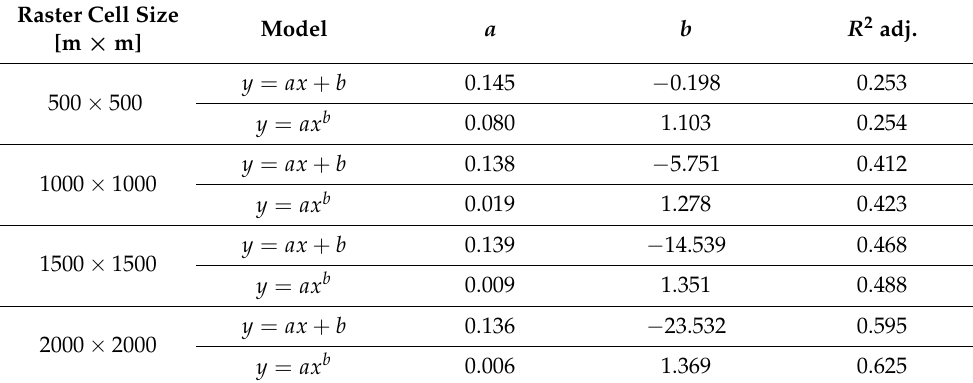
Table 1. Functional forms, values of parameters, and adjusted R 2 obtained when modelling the dependency between the number of emergency cases and the residential population while using differently sized raster